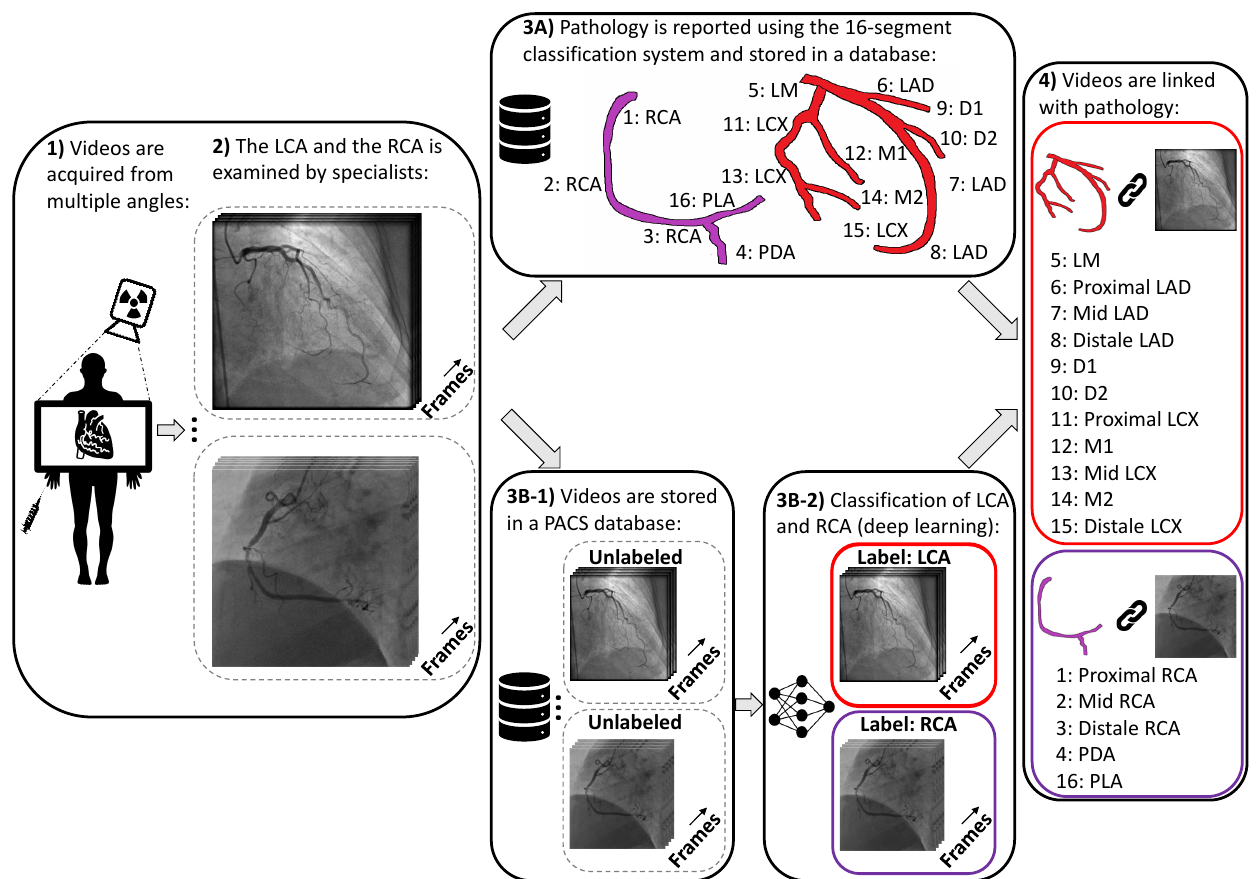
Figure 1. Overview of the proposed framework for linking CAGs and reported pathology. ( 1 ) Videos are recorded from various angles. ( 2 ) Videos are examined by specialists. ( 3A ) Pathology is reported in a database. ( 3B-1 ) Videos are stored, but there is no information about which videos contain LCA or RCA. ( 3B-2 ) Classification of LCA and RCA is performed using deep learning (the models presented in this paper). ( 4 ) Videos are merged with databases containing pathological